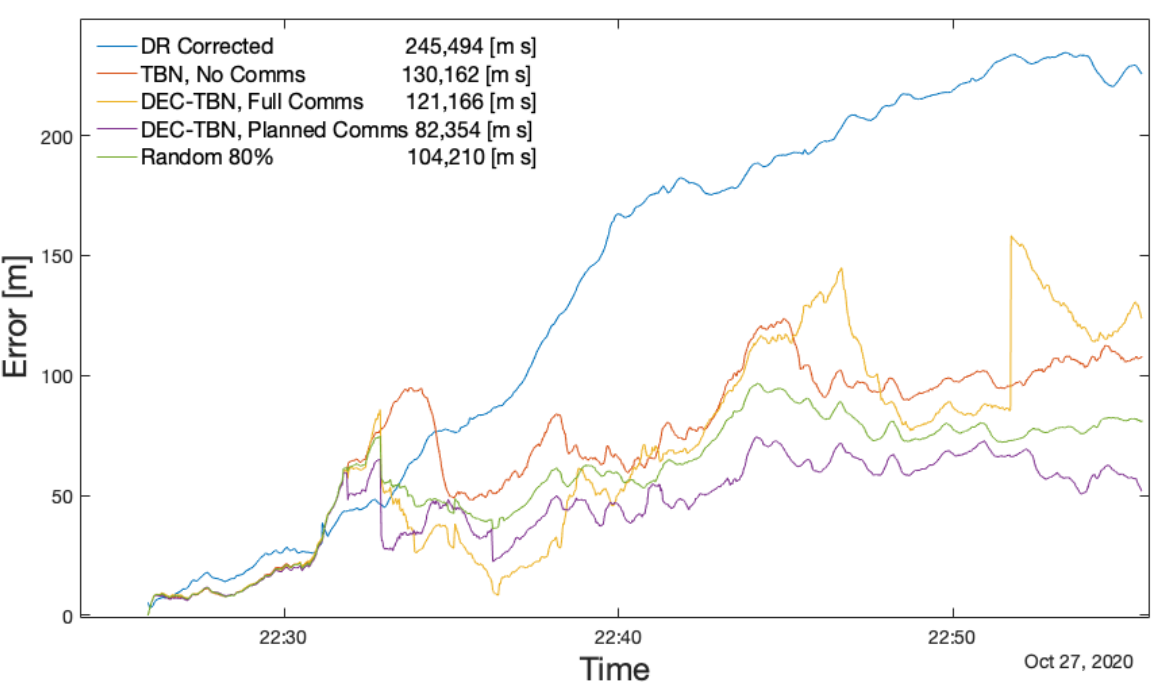
Figure 14. Joint Error for Mission 3. The planning algorithm produced the lowest total error using four communications. It was followed closely by a random policy that used six communications. In this case, the 80% random communication regime produced the lowest total error of the random communication